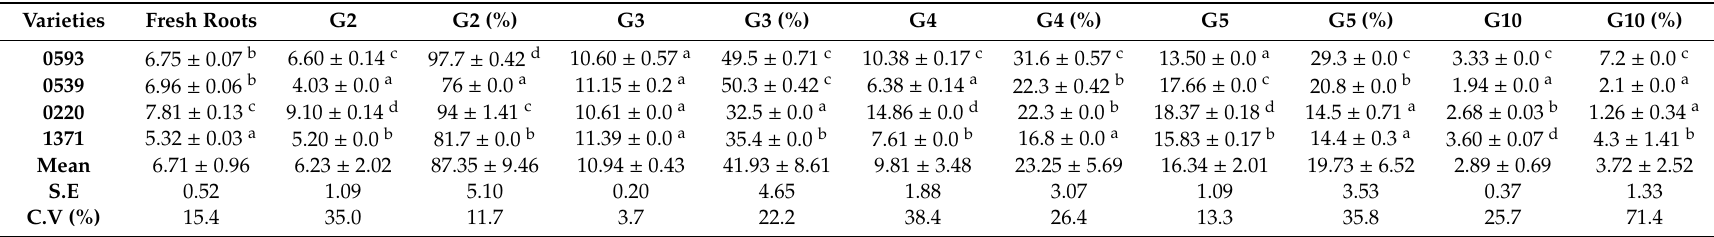
Table 1. β -carotene ( µ g / g) concentrations (fresh weight basis) and their percentage true retention in cassava products from yellow cassava varieties (one-day fermentation) 1 .